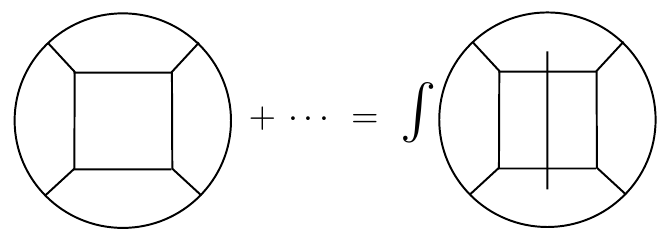
Figure 4 . The full one-loop correlator, equal to a sum over many Witten diagrams, is reconstructed from the double-discontinuity in a single